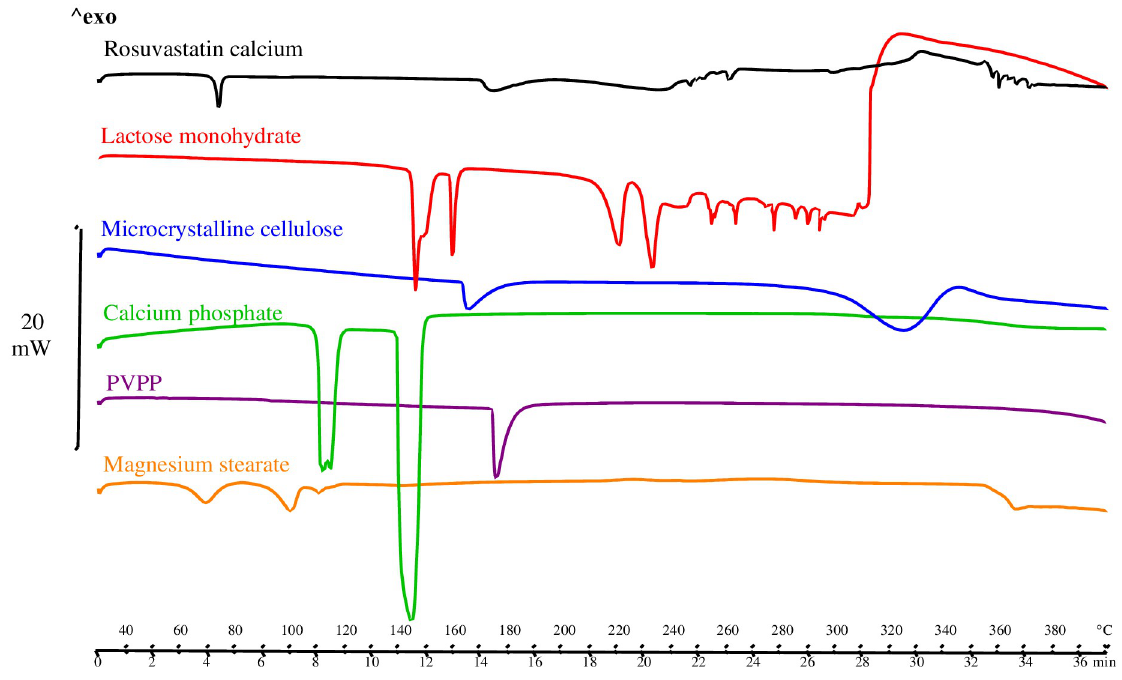
Fig 5. DSC rosuvastatin calcium and selected